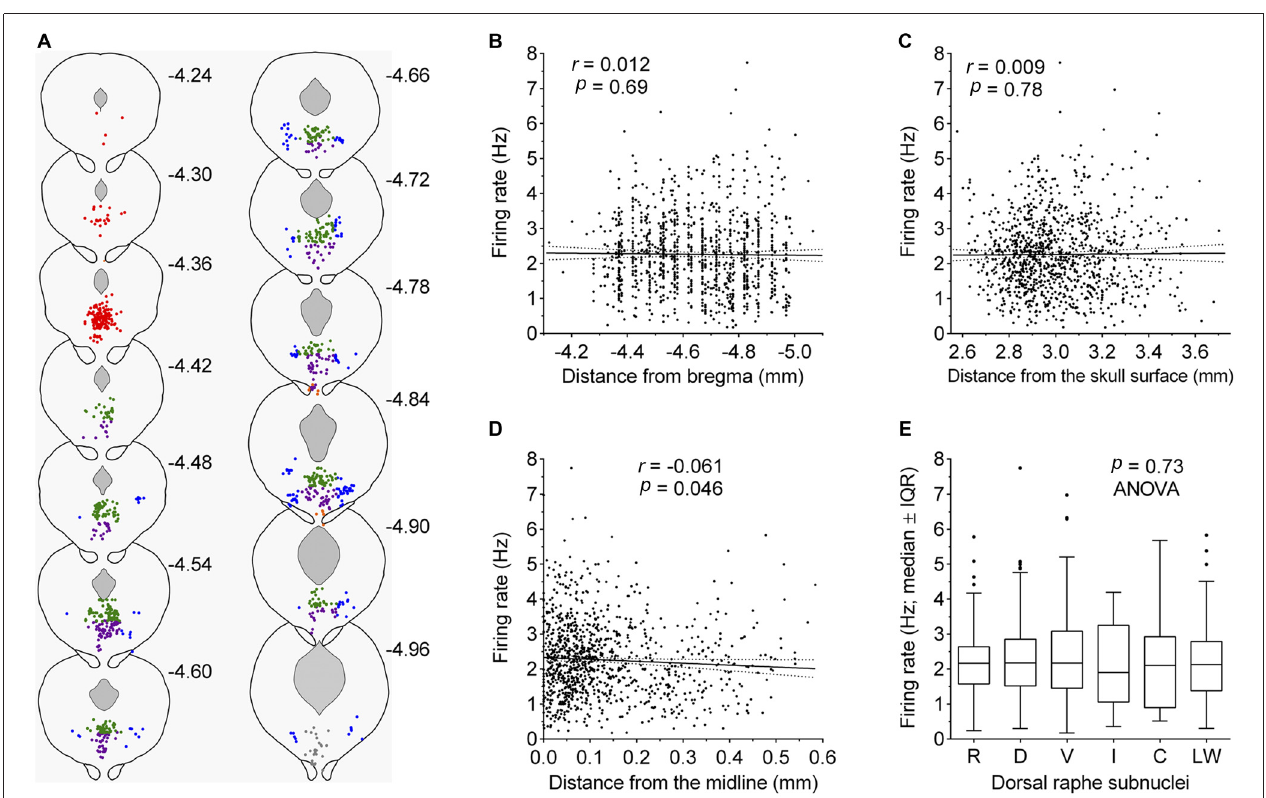
FIGURE 5 | Firing rate of serotonergic neuron is constant across the DRN. (A) Coronal sections showing the anatomical location of recorded serotonergic neurons; adaptations from Paxinos and Franklin (2001). Numbers indicate distance of the section from bregma. Symbols represent individual neurons. Colors indicate dorsal raphe subnuclei: red, rostral; green, dorsal; violet, ventral; orange, interfascicular; gray, caudal; blue, lateral wings. (B–D) Correlation between the firing rate and neuron location along the rostrocaudal axis (B) , the dorsoventral axis (C) , and the lateral distance from the midline (D) . In (C) , numbers on abscissa correspond to numbers on the right margin of coronal plates in mouse brain atlas (Paxinos and Franklin, 2001) and represent dorsoventral distance from the horizontal plane passing through bregma and lambda on the surface of the skull. Symbols represent individual neurons. Lines represent linear regression and 95% CI. r denotes Pearson’s correlation coefficient. (E) Comparison of firing rates of neurons belonging to different dorsal raphe subnuclei. R, rostral; D, dorsal; V, ventral; I, interfascicular; C, caudal subnucleus; L, lateral wings. Median firing rates and number of recorded neurons per each subnucleus are: R, 2.16 Hz ( n = 165); D, 2.18 Hz ( n = 440); V, 2.17 Hz ( n = 290); I, 1.90 Hz ( n = 11); C, 2.11 Hz ( n = 27), L, 2.13 Hz ( n =